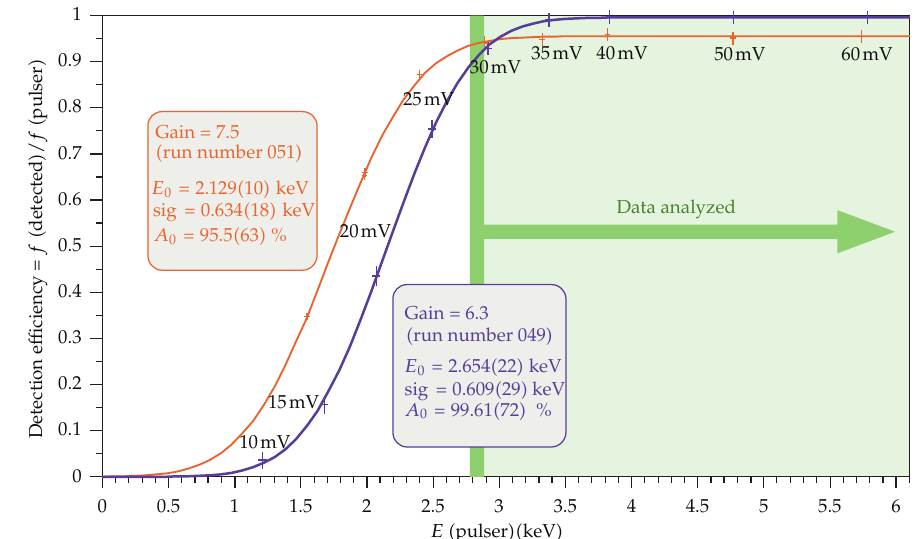
Figure 6: Low-energy threshold function measured with 50Hz pulser at several amplitudes. Decreasing of the “hard” threshold minimizes the correction value but also decreases total detection e ffi ciency (cid:2) because of higher load and therefore higher dead time (cid:3)